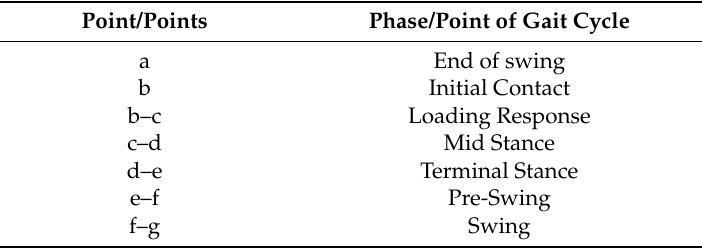
Figure 11. Normalized thigh angle, gyro signal, and time derivative of gyro signal. Table 2. Phases of gait cycle as identified in the thigh angle waveform.